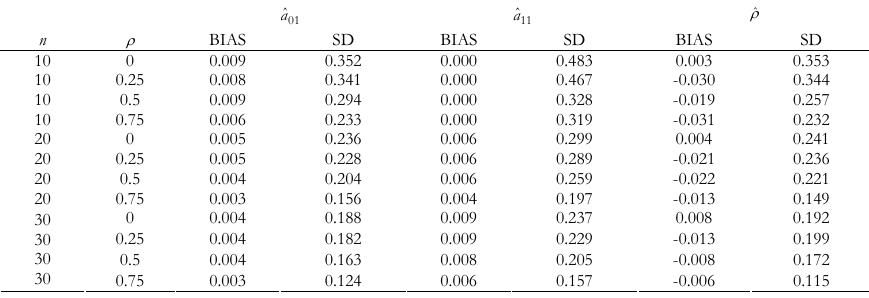
Synthesized results of the simulation referred to the simplified procedure based on ordered means: N = 1000, r = 1 01 ˆ a 11 ˆ a